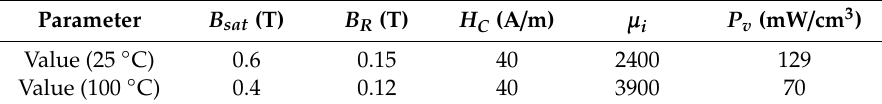
Figure 5. Tested inductors containing toroidal cores. Table 1. Values of selected parameters of material F867 [43].